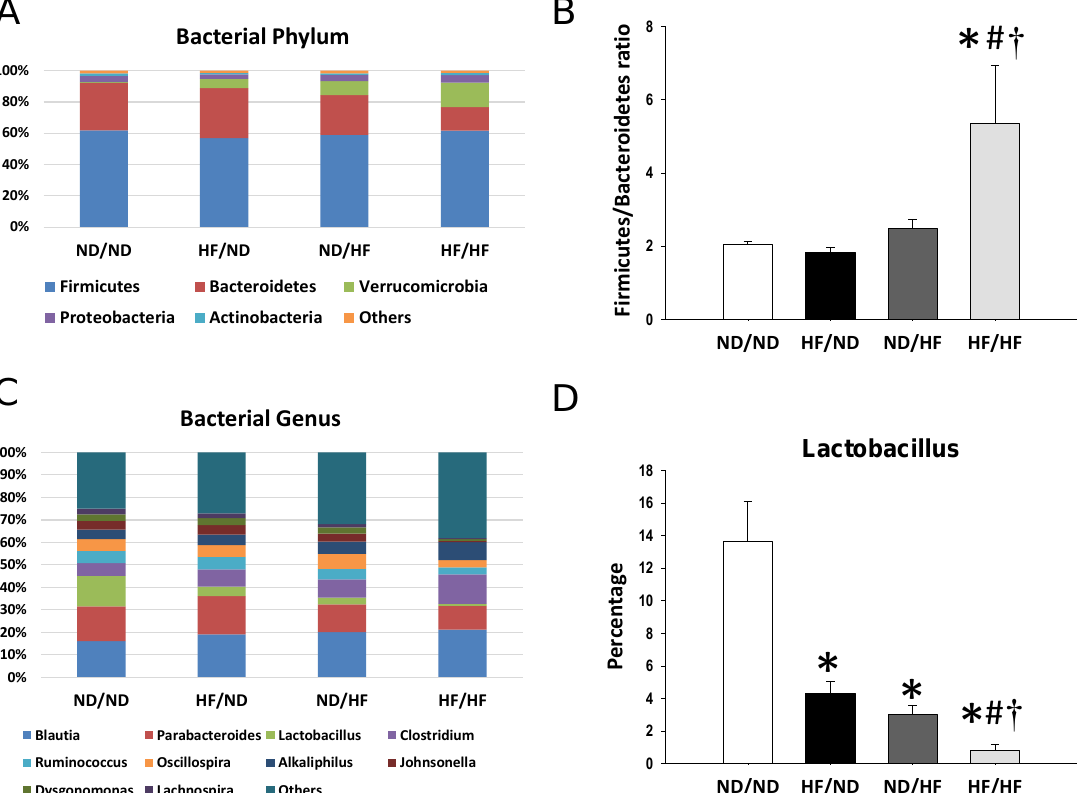
Figure 6. Effect of maternal and post-weaning high-fructose (HF) diet on offspring gut microbiota at 16 weeks of age. ( A ) Relative abundances of the top five phyla. ( B ) The Firmicutes to Bacteroidetes ratio. ( C ) Relative abundances of the top 10 genera. ( D ) Relative abundances of the genus Lactobaccilus . n = 8/group. * p < 0.05 vs. ND/ND; # p < 0.05 vs. HF/ND; † p < 0.05 vs. ND/HF.